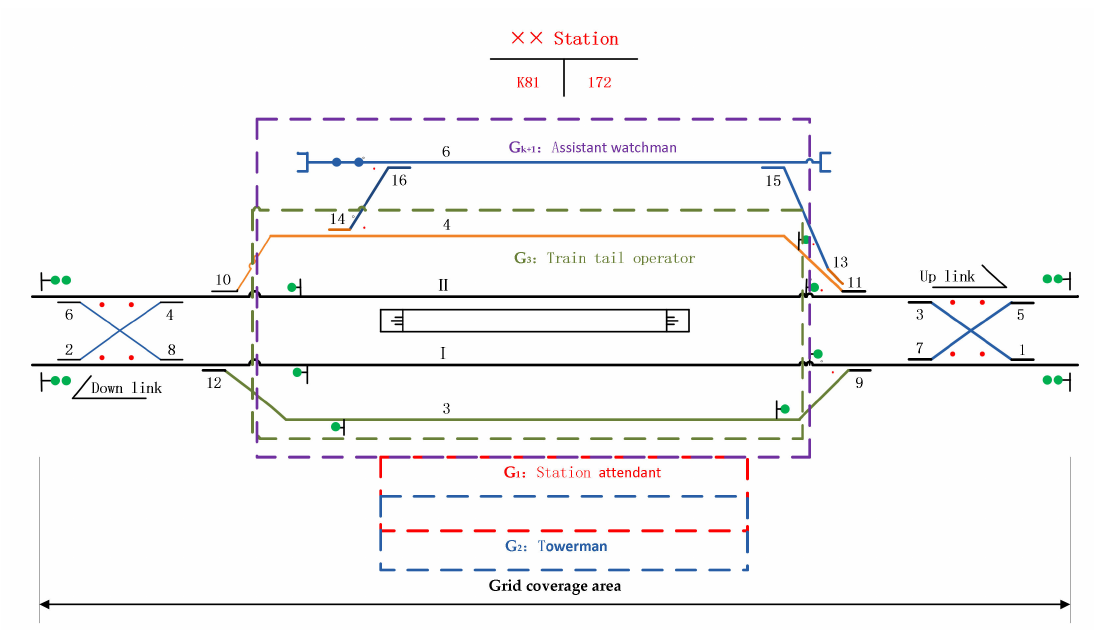
Figure 3. Railway station grid division; 1, 2, 3, 4, 6 (in the middle of the picture) represent tracks; 1–16 (at both ends of the picture) represent turnouts.